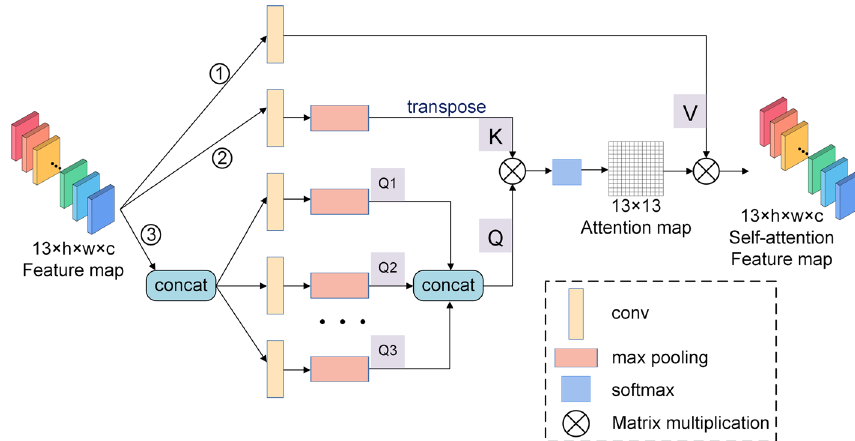
Fig. 4 Scaled dot-product self-attention calculation in this BAA model